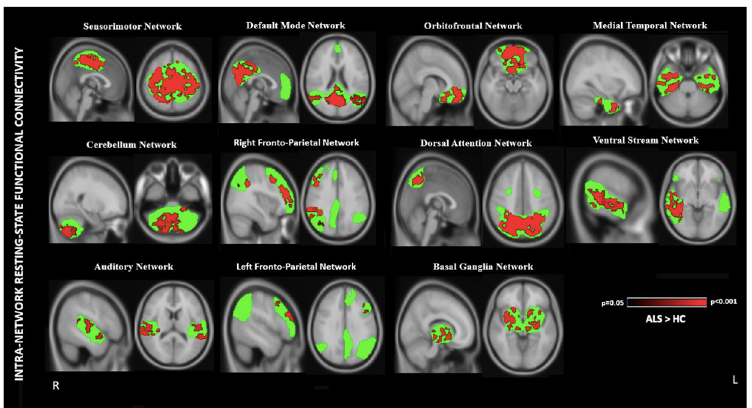
Fig 2. Resting-state networks (RSNs) displayed significant intra-network resting-state functional connectivity (Rs-FC) differences in Amyotrophic lateral sclerosis (ALS) patients compared to healthy subjects (HC). Red: Higher Rs-FC in sensorimotor RSN, cerebellum RSN, auditory RSN, default mode RSN, right fronto-parietal RSN, left fronto-parietal RSN, orbitofrontal RSN, dorsal attention RSN, basal ganglia RSN, medial temporal RSN, ventral stream RSN. Green: Mask obtained from the respective RSNs. Results were corrected for multiple comparisons using the family-wise error approach ate p < 0.05. The color bar represents 1-p values. Brain maps are shown in radiological